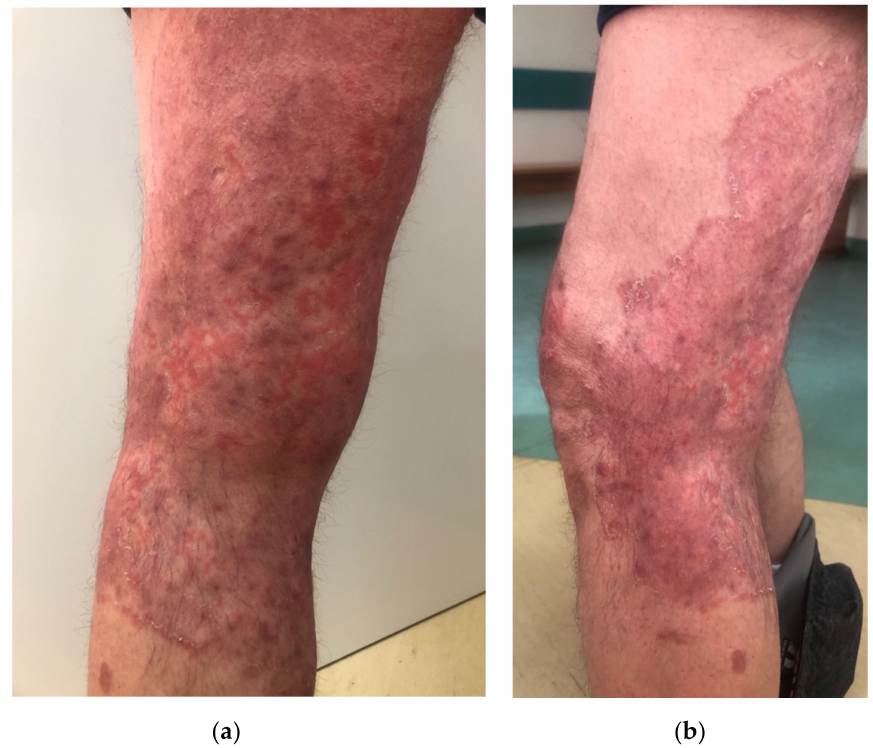
Figure 2. At the admission. Close-up view of the lesions on of the left tight, posterior ( a ) and lateral ( b ) side.